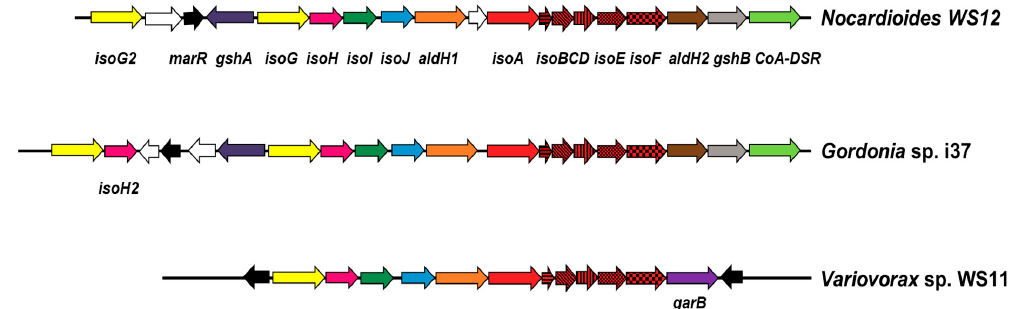
Figure 1. Isoprene degradation gene cluster of Nocardioides sp. WS12 compared to the corresponding gene clusters of another Actinobacterial isoprene degrader, Gordonia sp. i37 and the Gram-negative isoprene degrader Variovorax sp. WS11.